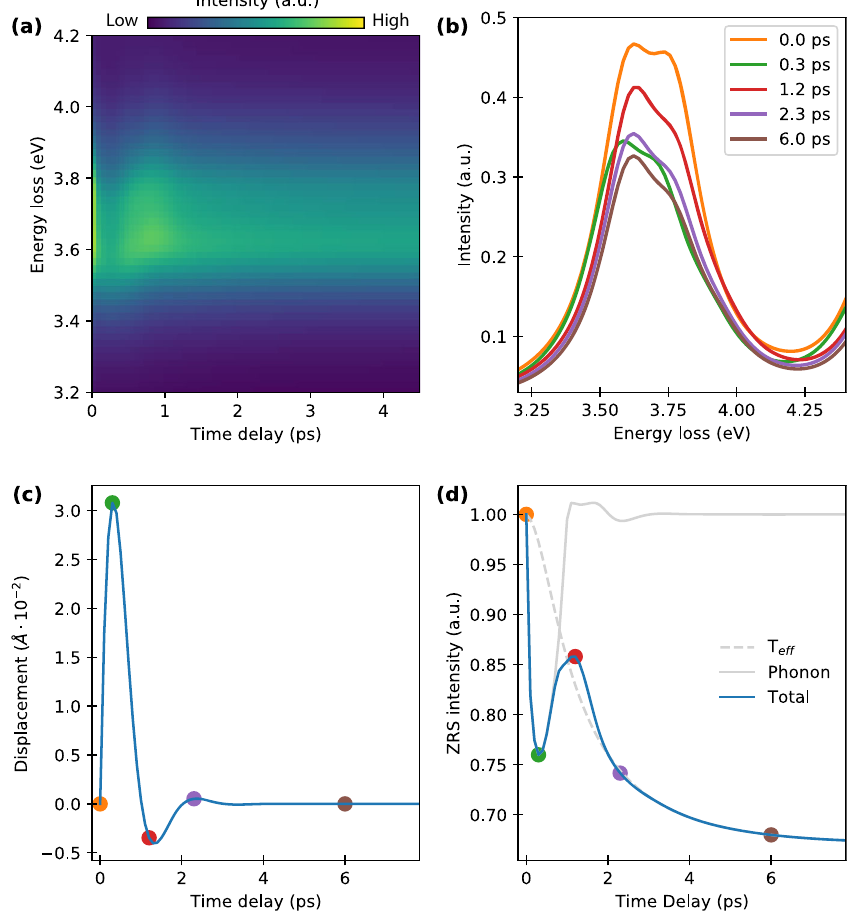
Fig. 4 Calculated trRIXS spectra in the region of the ZRS. a O K -edge RIXS in the vicinity of the ZRS excitation as a function of the time-delay, calculated using the Cu 3 O 8 cluster model. b Calculated O K -edge RIXS spectra at selected time-delays. c Time evolution of the atomic displacement used in the calculation, including phenomenological exponential damping. d Computed time evolution of the ZRS intensity. The solid and dashed gray lines represent the effect of the lattice vibration and of the effective temperature on the computed ZRS intensity, respectively. The colored dots in the time traces of panels ( c , d ) represent time-delays chosen for the calculated RIXS spectra shown in panel ( b ), with the same color code. Full details of the calculations are provided in Supplementary Note